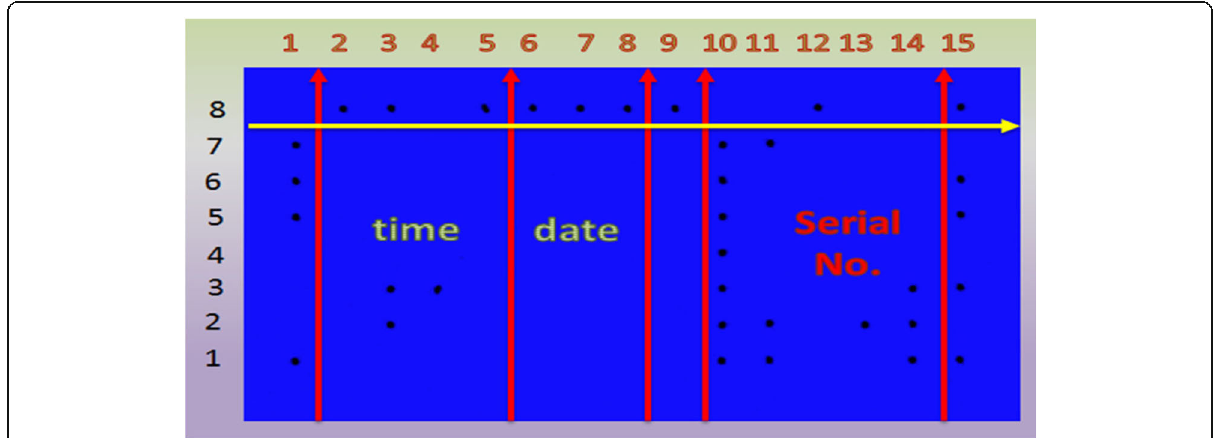
Fig. 7 The RGB mode of the coded dots matrix embedded in a color laser printout of Xerox® sample